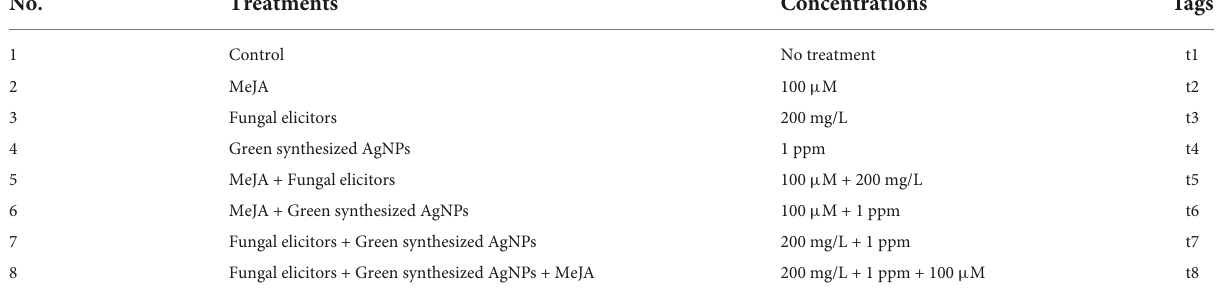
TABLE 1 Different treatments with